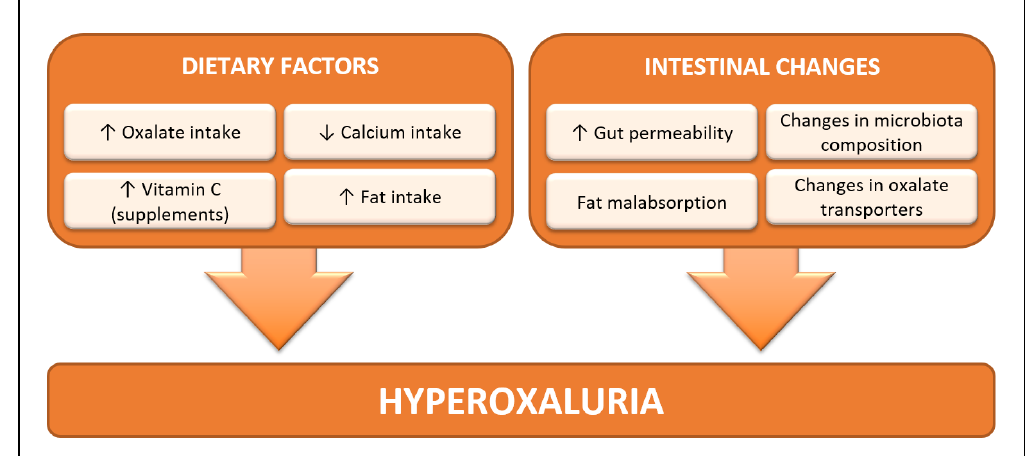
Figure 1. Hypothetical underlying mechanisms for hyperoxaluria after bariatric surgery (BS). A diet rich in oxalate or poor in calcium content decreases the amount of poorly soluble, nonabsorbable calcium oxalate (CaOx) complexes in the intestinal lumen leading to a higher amount of free oxalate for absorption. Vitamin C (ascorbic acid) supplements are metabolized to oxalate contributing to hyperoxaluria. BS predisposes to the development of fat malabsorption, which in the presence of a high dietary fat intake further enhances free oxalate absorption due to the sequestration of calcium by fat. The increased intestinal exposure to complexes of unconjugated bile salts and fatty acids could affect microbiota composition and also decrease the colonization by Oxalobacter formigenes and other oxalate-degrading bacteria. Increased gut permeability induced by excessive unconjugated bile salts and other factors may occur. Finally, changes in intestinal oxalate transporters could lead to increased net intestinal oxalate absorption.